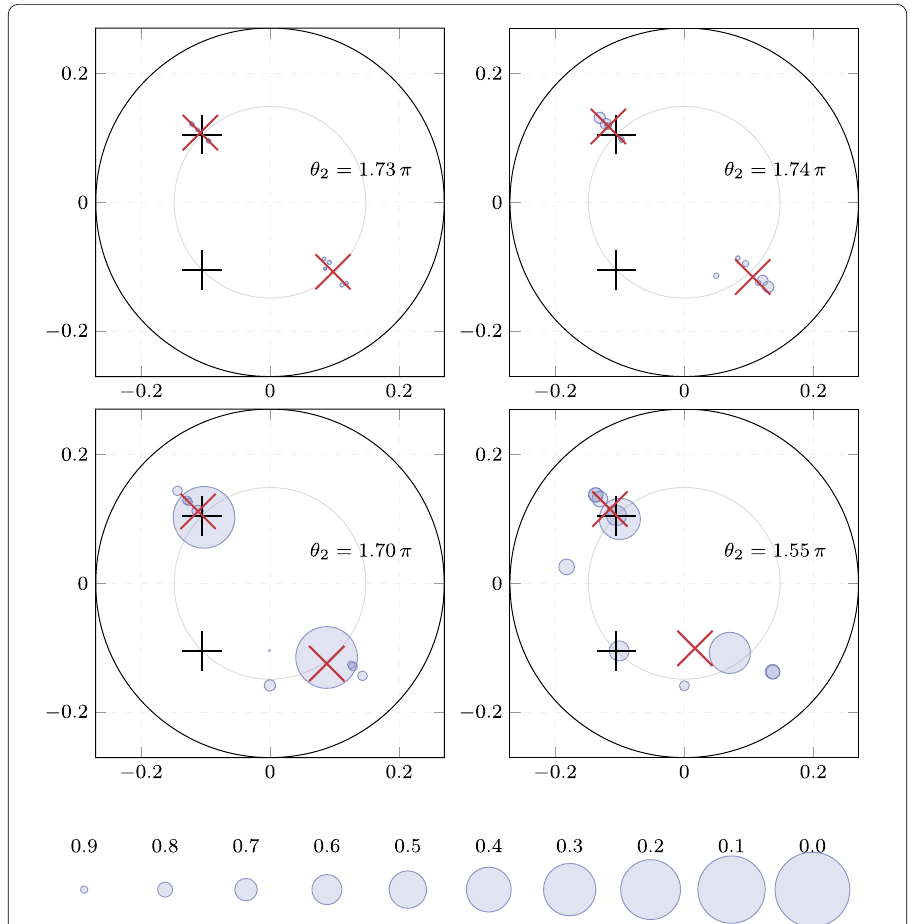
Figure 7 Optimization of nozzles’ positions. Results obtained for levels 2 (top) and 3 (bottom), J 1 (left), and J 2 (right). The reduction of the functionals is depicted in accordance with the legend, i.e., the size of the circles represents 1 – R i with the corresponding reduction R i from equation (8). The red crosses are the computed weighted centers, see equation (9). The black plus signs indicate the default positions of the nozzles as